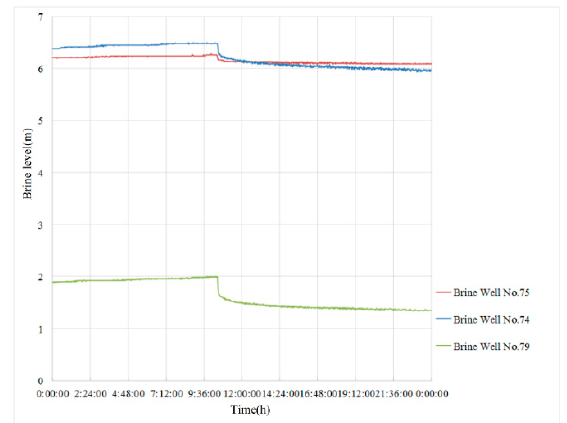
Figure 11. Measuring results of the brine level.